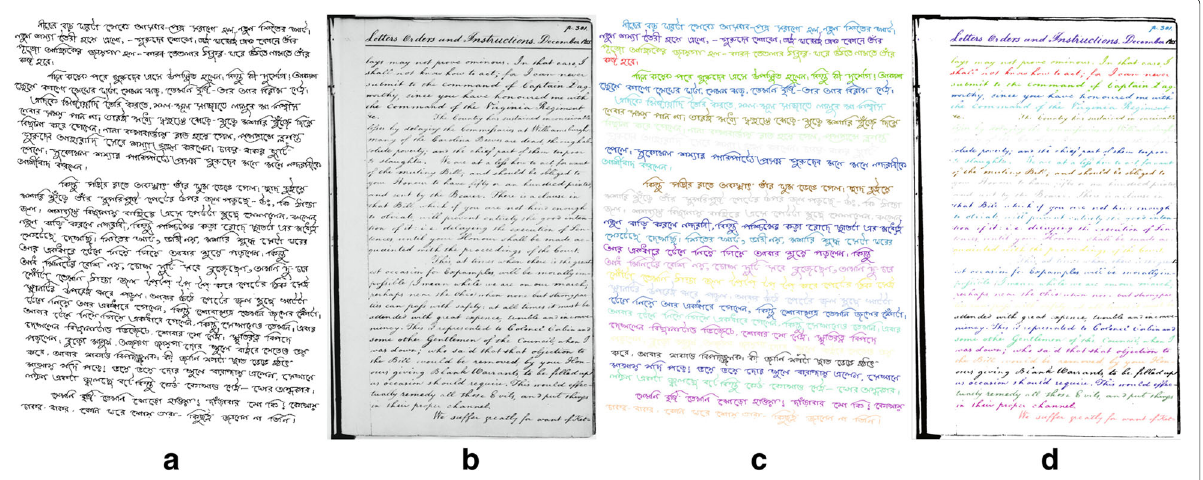
Fig. 10 Experimental results on conventional datasets: a Image in the ICDAR 2013 dataset. b Image in the George Washington dataset. c Textline extraction result of a . d Textline extraction result of b